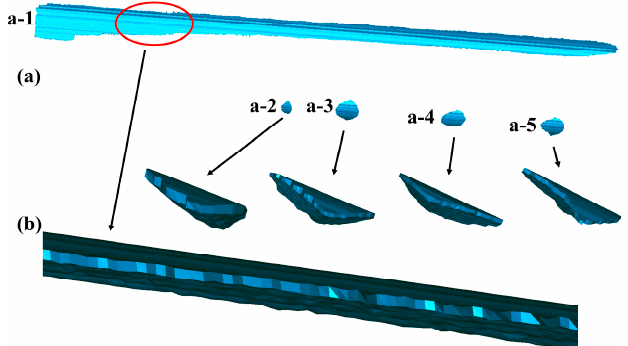
Figure 17. The triangulation of the PCM. ( a ) The triangle-meshes of the reference PCM; ( b ) The triangle-meshes of the scratch-surface PCM.